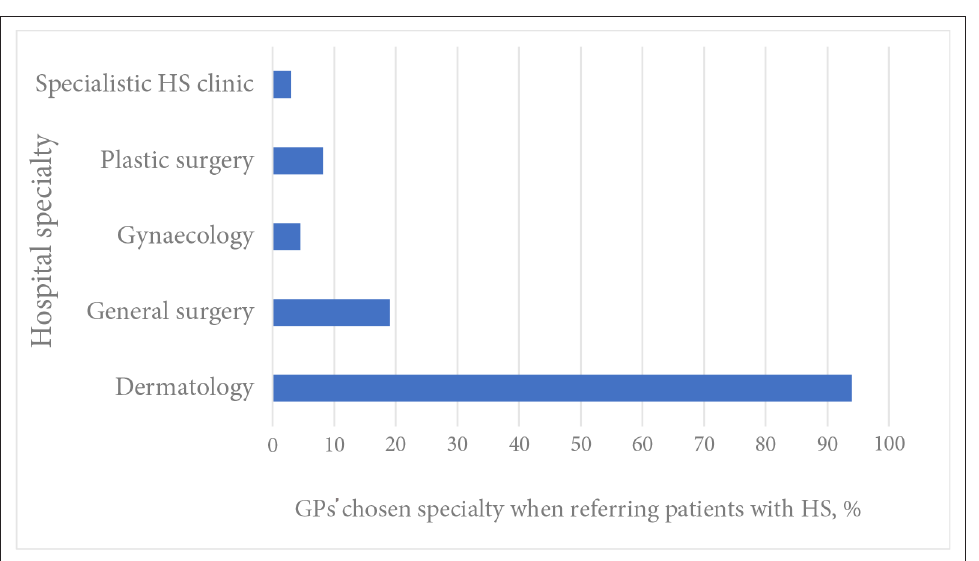
Figure 2 GPs’ choice of specialty when referring patients with hidradenitis suppurativa (HS) to secondary